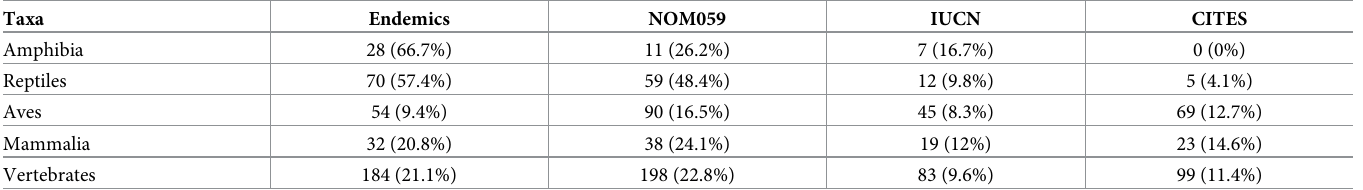
Table 2. Conservation status of vertebrate species in Colima, Mexico; NOM059 (Mexican red list), IUCN, CITES; (% = Colima species with respect to Mexican species).